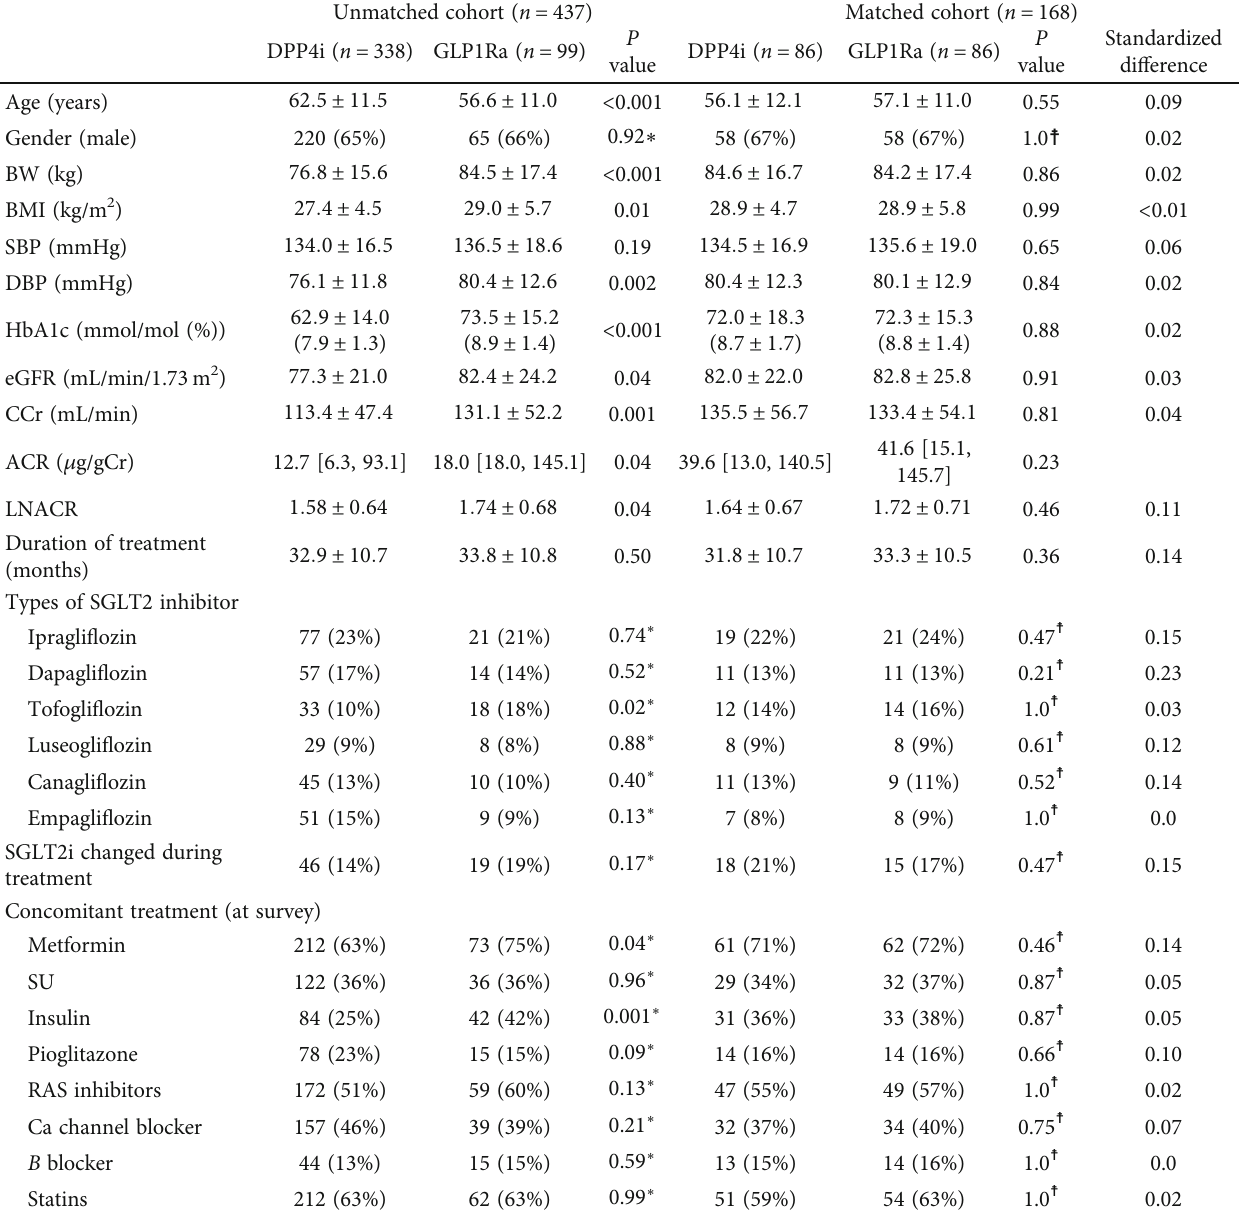
Table 1: Baseline characteristics before and after propensity score